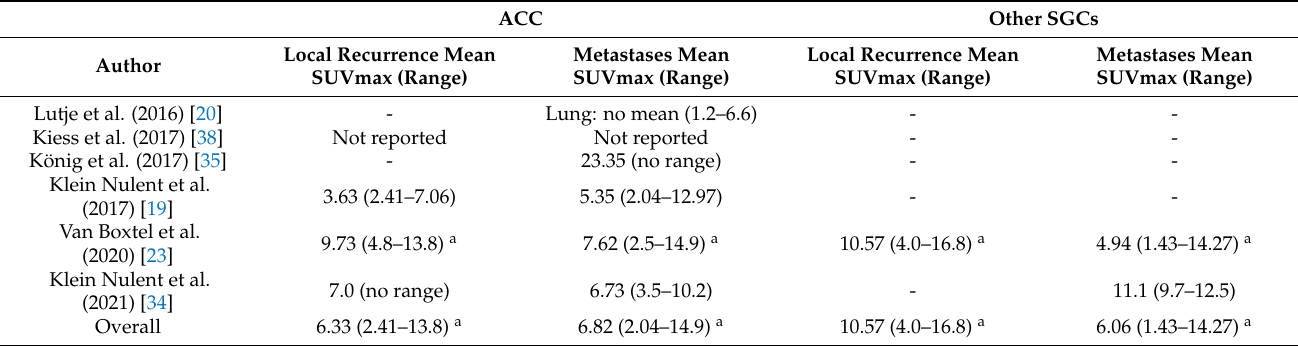
Table 2. Mean values of PSMA PET SUVmax and range of SUVmax for locally recurrent and metastatic ACC and other SGCs.